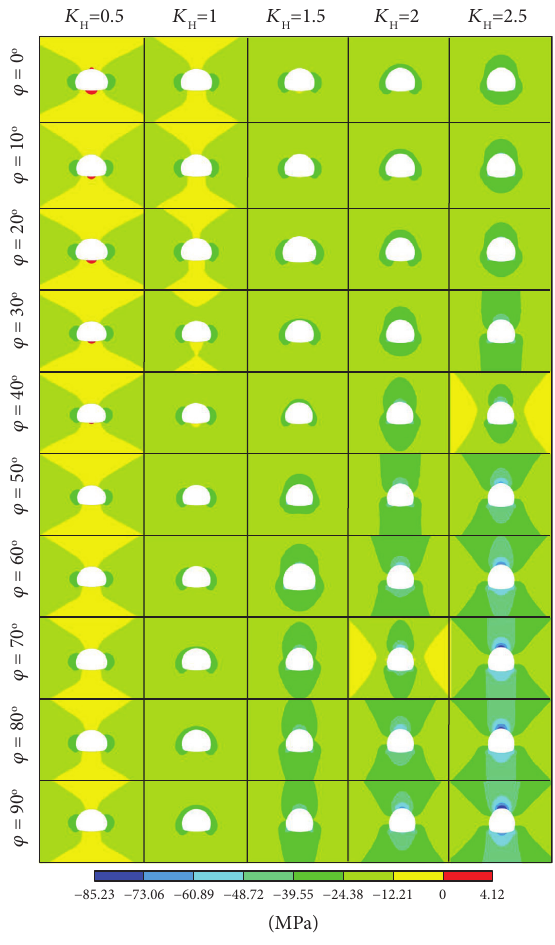
Figure 7: The distribution of tangential stress σ rock of the tunnel under various simulation conditions (the tensile stress is positive and the compressive stress is